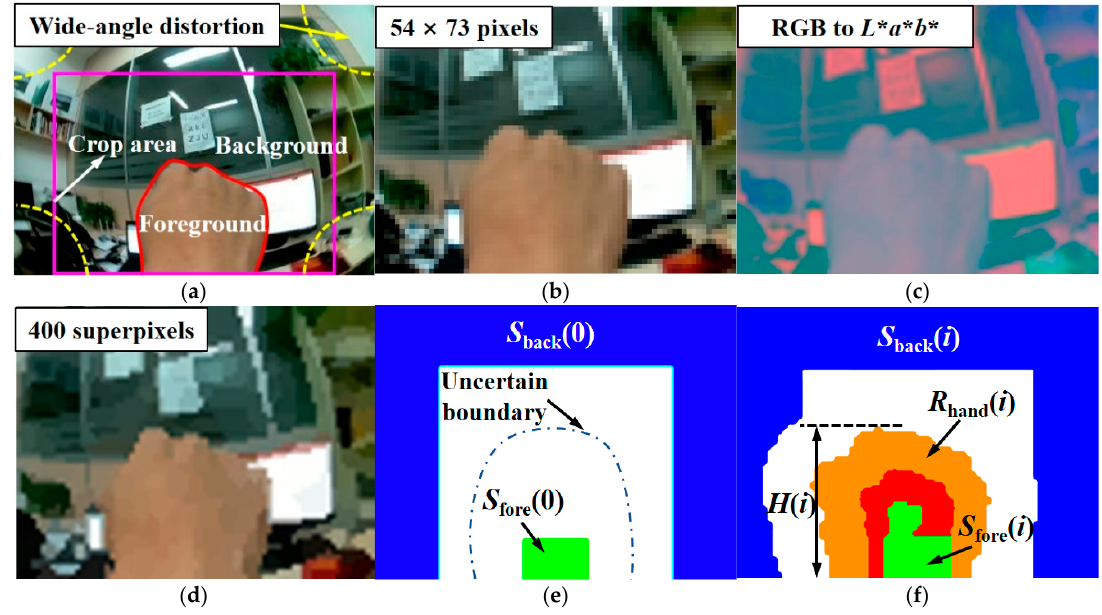
Figure 5. The processing of video image for hand region segmentation: ( a ) Original red–green–blue (RGB) image; ( b ) Image after compressing and cutting pixels; ( c ) RGB image is transformed into L*a*b* color space; ( d ) The superpixels result of the simple linear iterative cluster (SLIC) algorithm; ( e ) Seed pixels of the foreground and background for the lazy snapping algorithm; ( f ) The result of hand region segmentation using the lazy snapping algorithm.